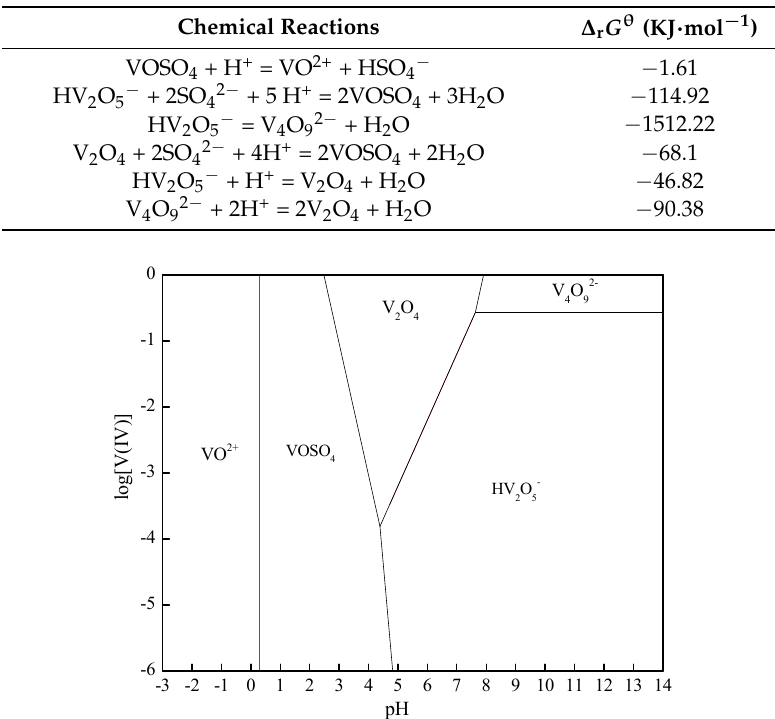
Table 1. Chemical reactions and Δ r G θ in the V(IV)-S-H 2 O system at 278.15 K ( Δ r G θ data were obtained from the literature [35]).